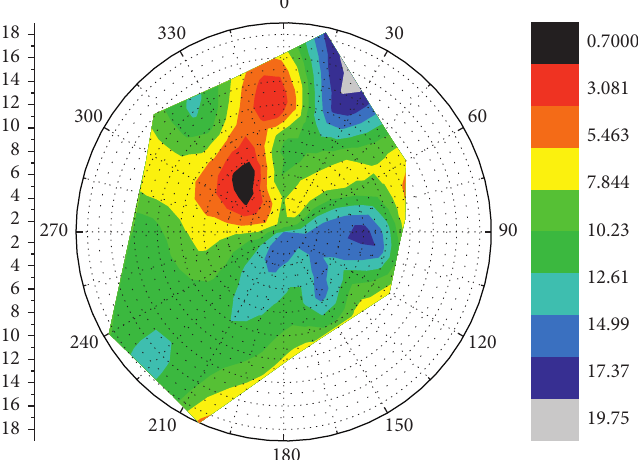
Figure 7: Effect of the number of negative samples on the quality of word